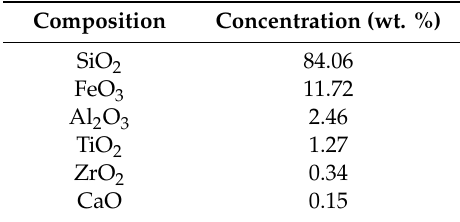
Table 1. Chemical composition of Botucatu Sandstone.